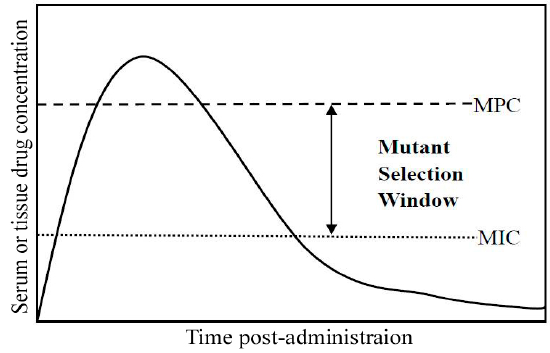
Figure 1. Pharmacodynamic characteristics of the mutant selection window. Drug concentrations indicated by the double-headed arrow between the mutant prevention concentration (MPC) and minimal inhibitory concentration (MIC) represent the mutant selection window.